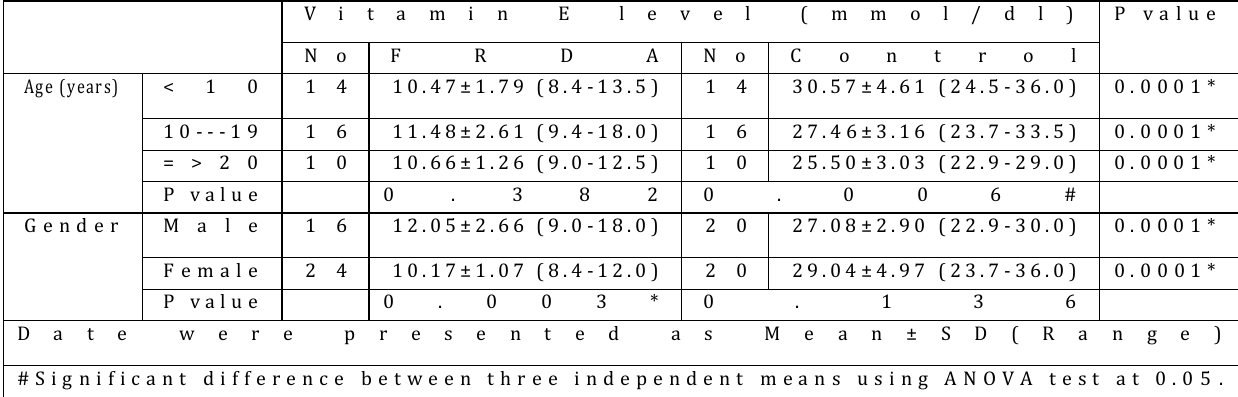
Figure (3-1) the level of vitamin E for the (FRDA) and control according to age and gender.